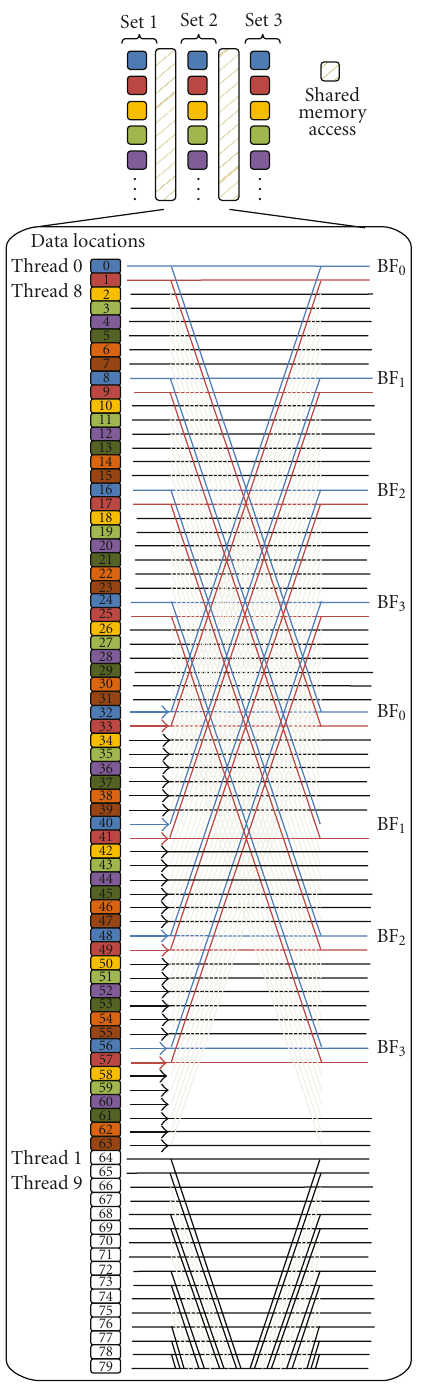
Figure 10: The workings of the new algorithm.